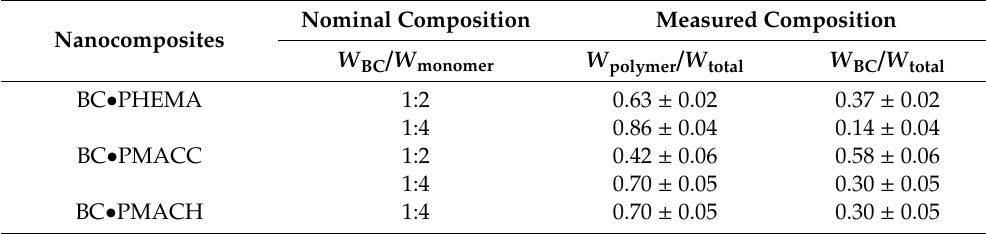
Table 1. List of the prepared nanocomposites with the respective weight